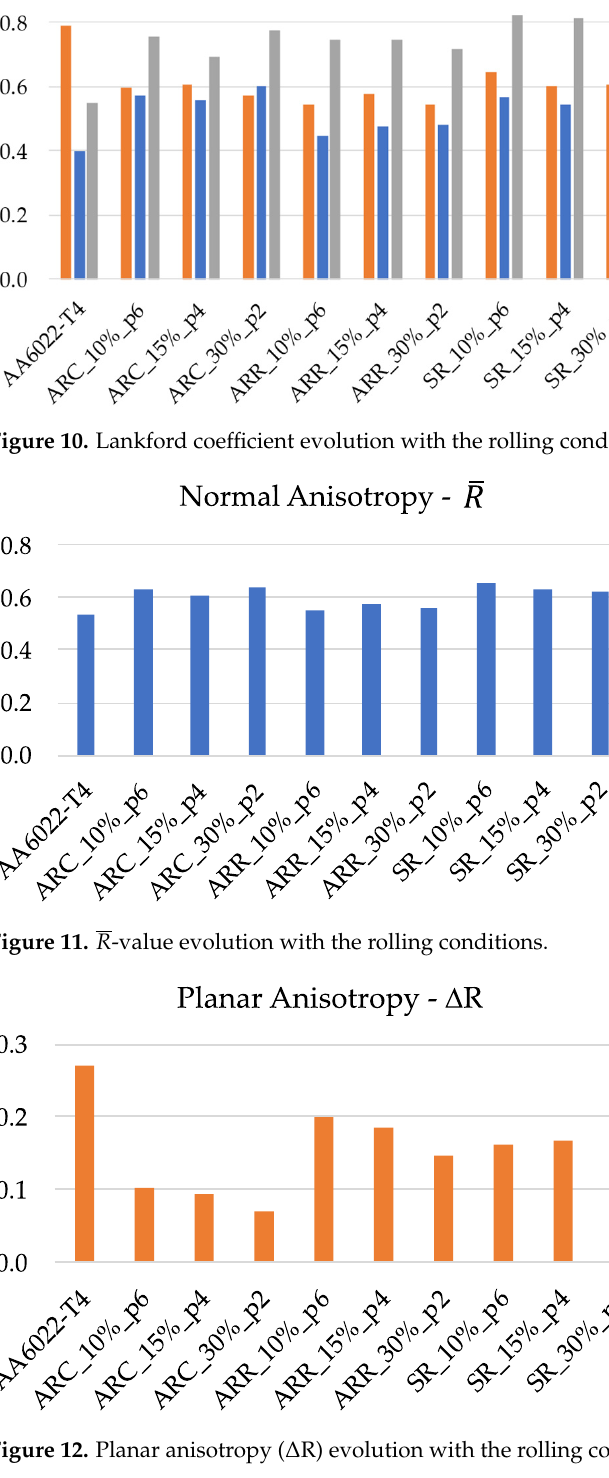
Figure 12. Planar anisotropy ( Δ R) evolution with the rolling conditions.